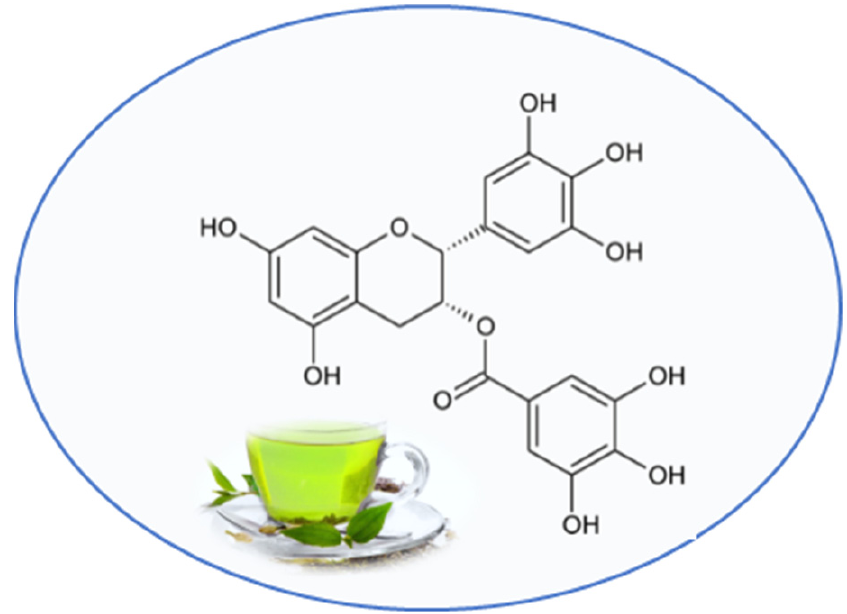
Figure 2. Chemical structure of epigallocatechin 3-gallate.